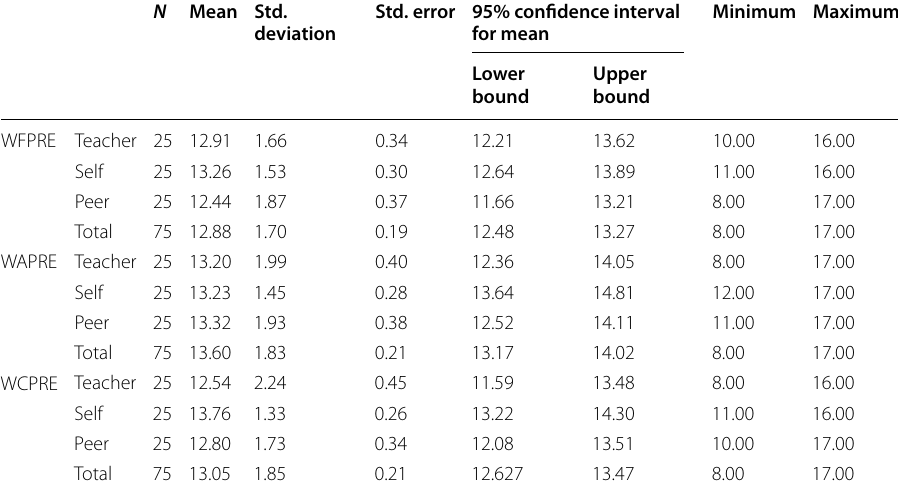
Table 6 Descriptive statistics of all groups on the pretests of writing accuracy, fluency, and complexity N Mean Std. Std. error 95% confidence interval deviation for mean